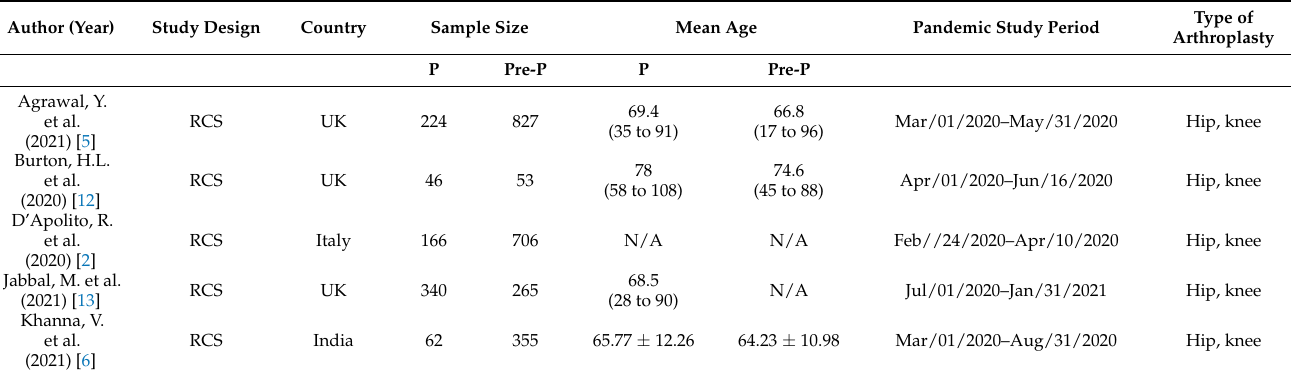
Table 2. Study design, demographic data, and study details of the included studies.